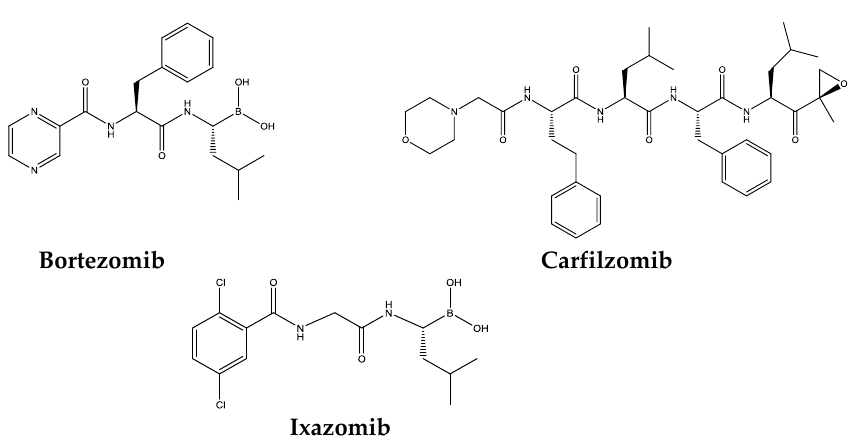
Figure 5. Molecular structure of the three proteasome inhibitors currently on the market.